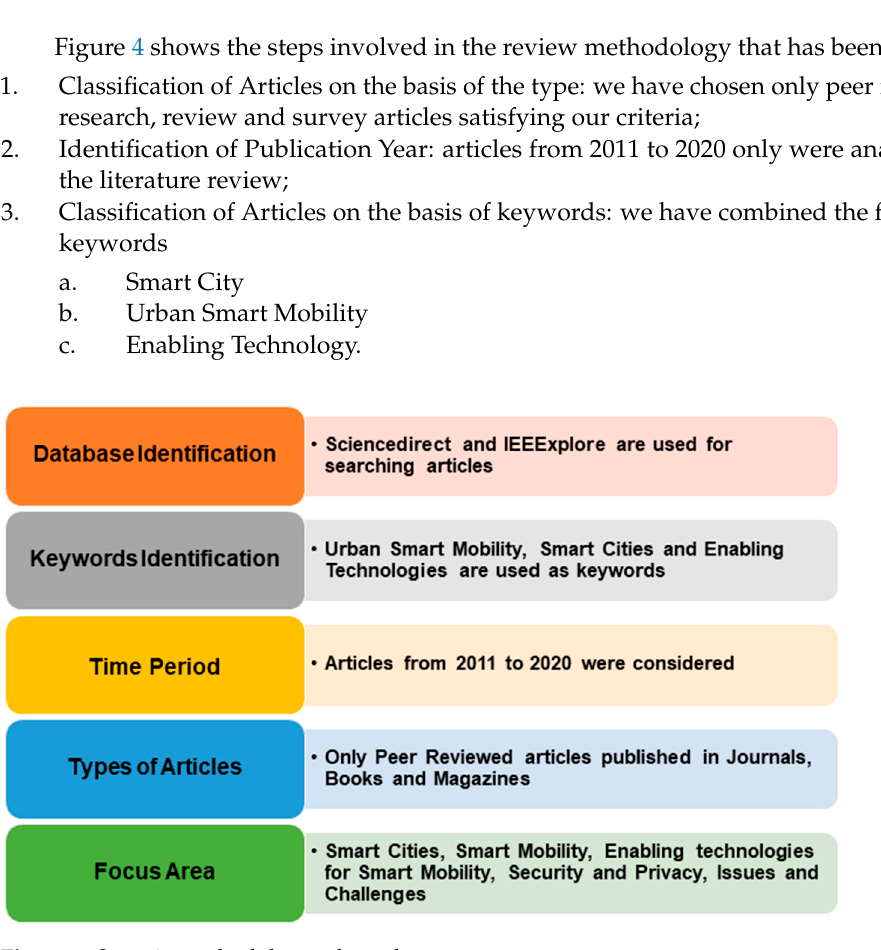
Figure 4. Steps in methodology adopted.